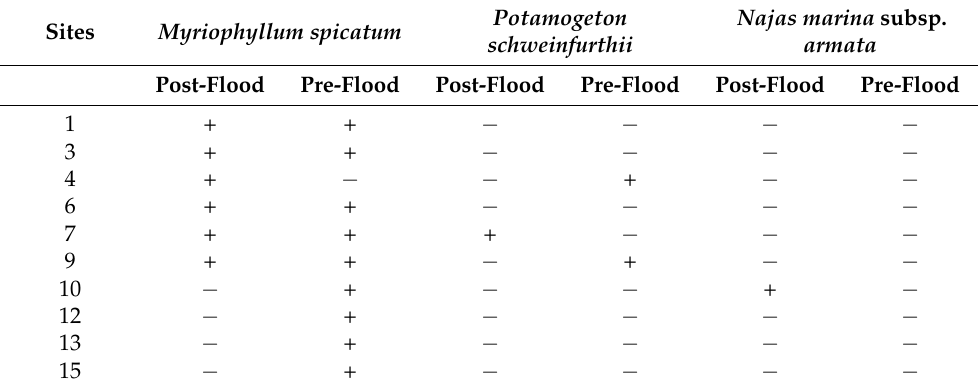
Table 7. Occurrence of the submerged macrophytes collected from Lake Nasser after (post-flood) and before (pre-flood)